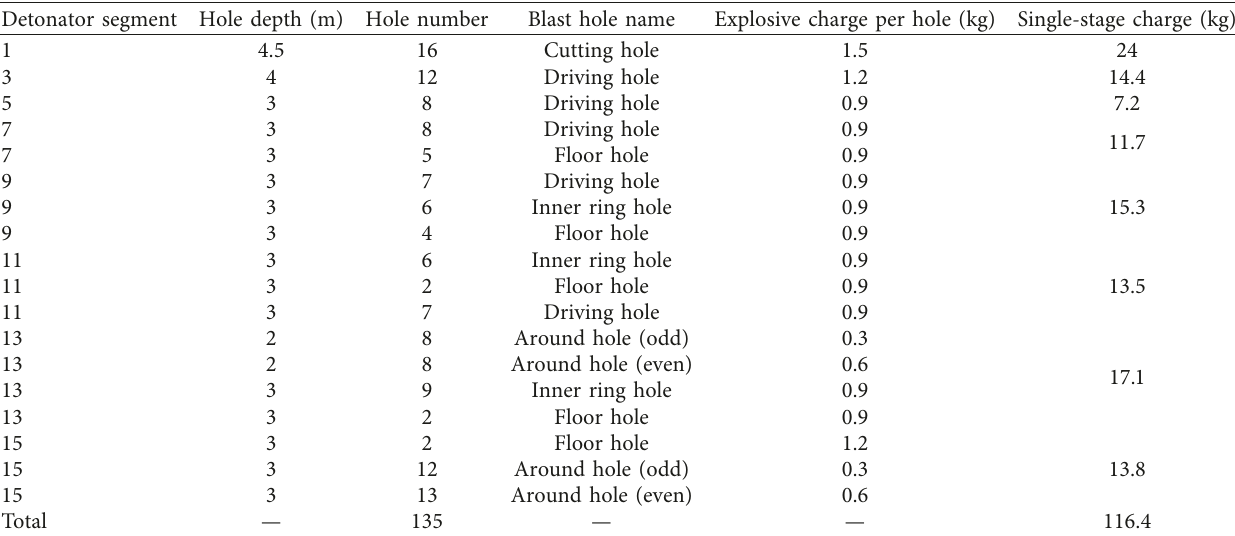
Figure 4. Each vibrometer has three channels, of which the horizontal direction is X and Y and the vertical direction is Z . It can collect the velocity, frequency, and duration of three different directions at the same time.